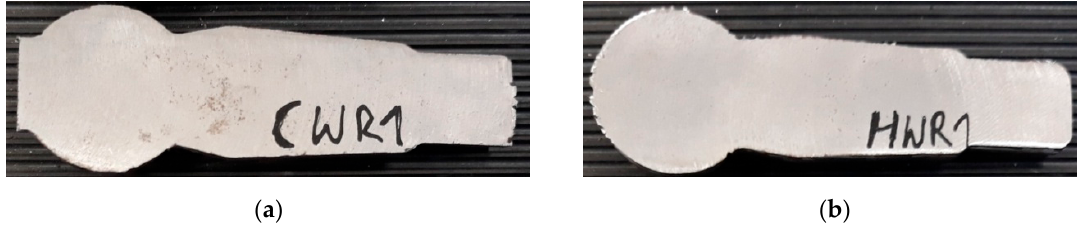
Figure 8. Ball studs obtained by: ( a ) the cross-wedge rolling (CWR) method; ( b ) the helical-wedge rolling (HWR) method, cut along their axis.